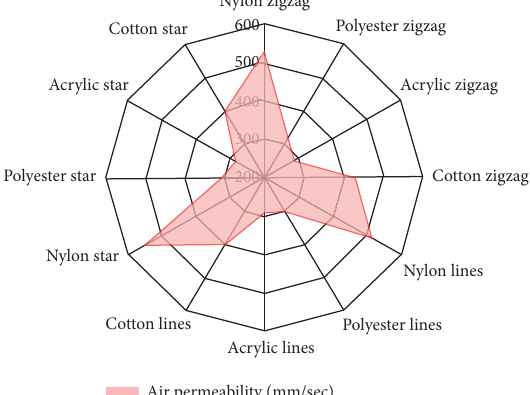
Figure 20: Air permeability of auxetic fabrics.